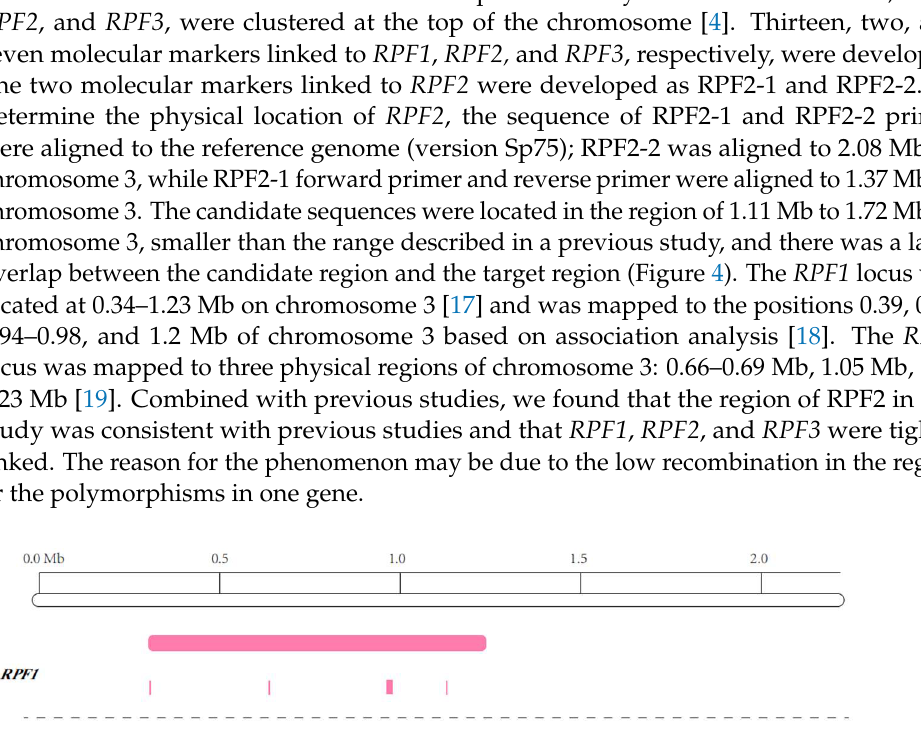
Figure 3. Amplification result of RPF2-IN12821 in BC 1.